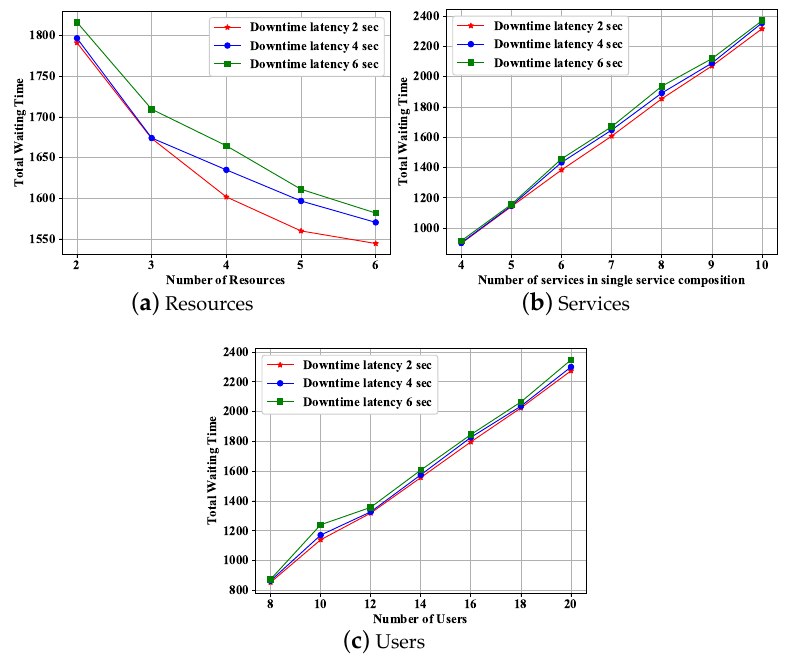
Figure 8. Impact of downtime on the total waiting